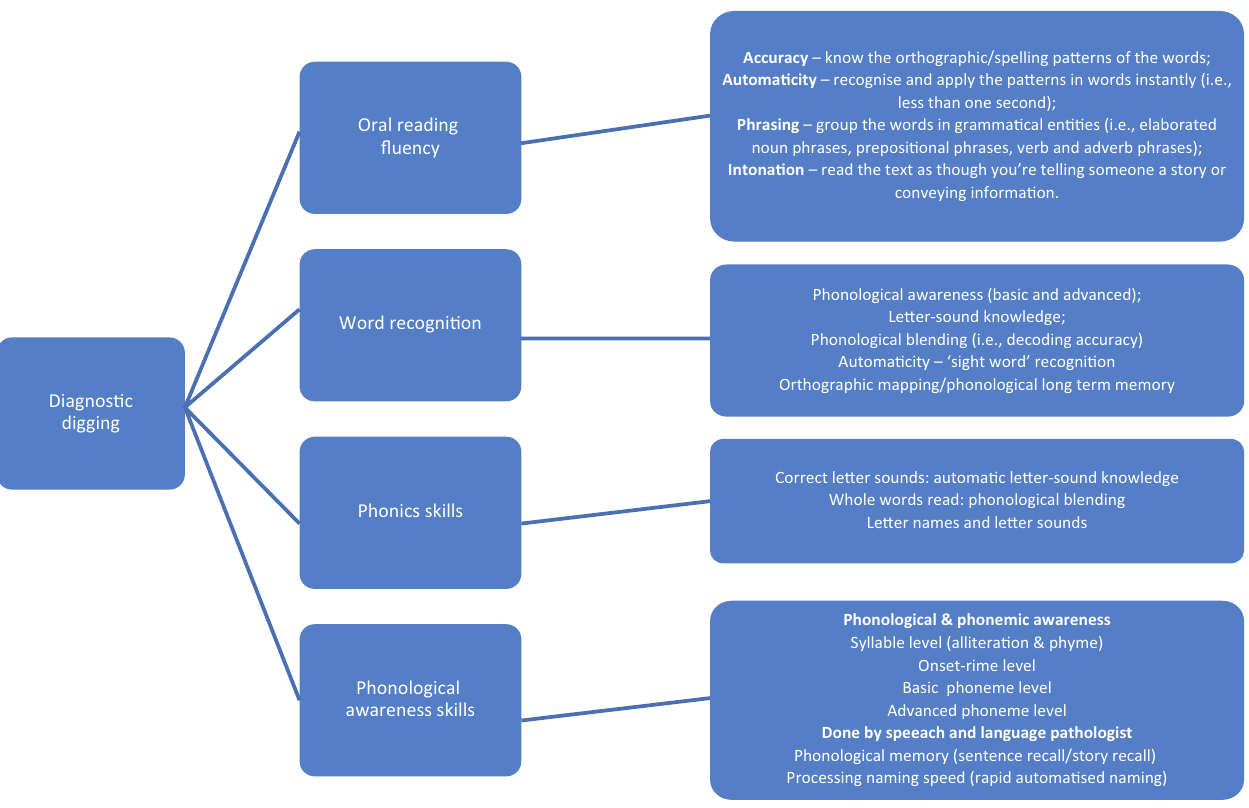
FIGURE 2: Reading literacy aspects to check.